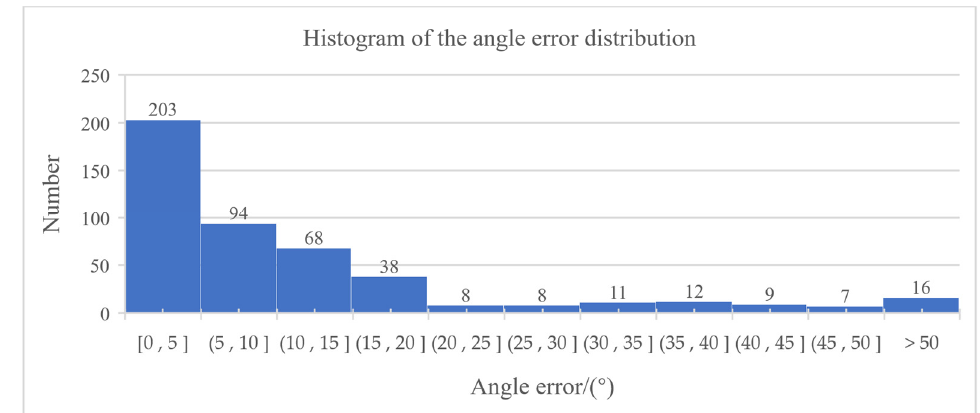
Figure 14. Histogram of angle error between calculated direction and measured direction.